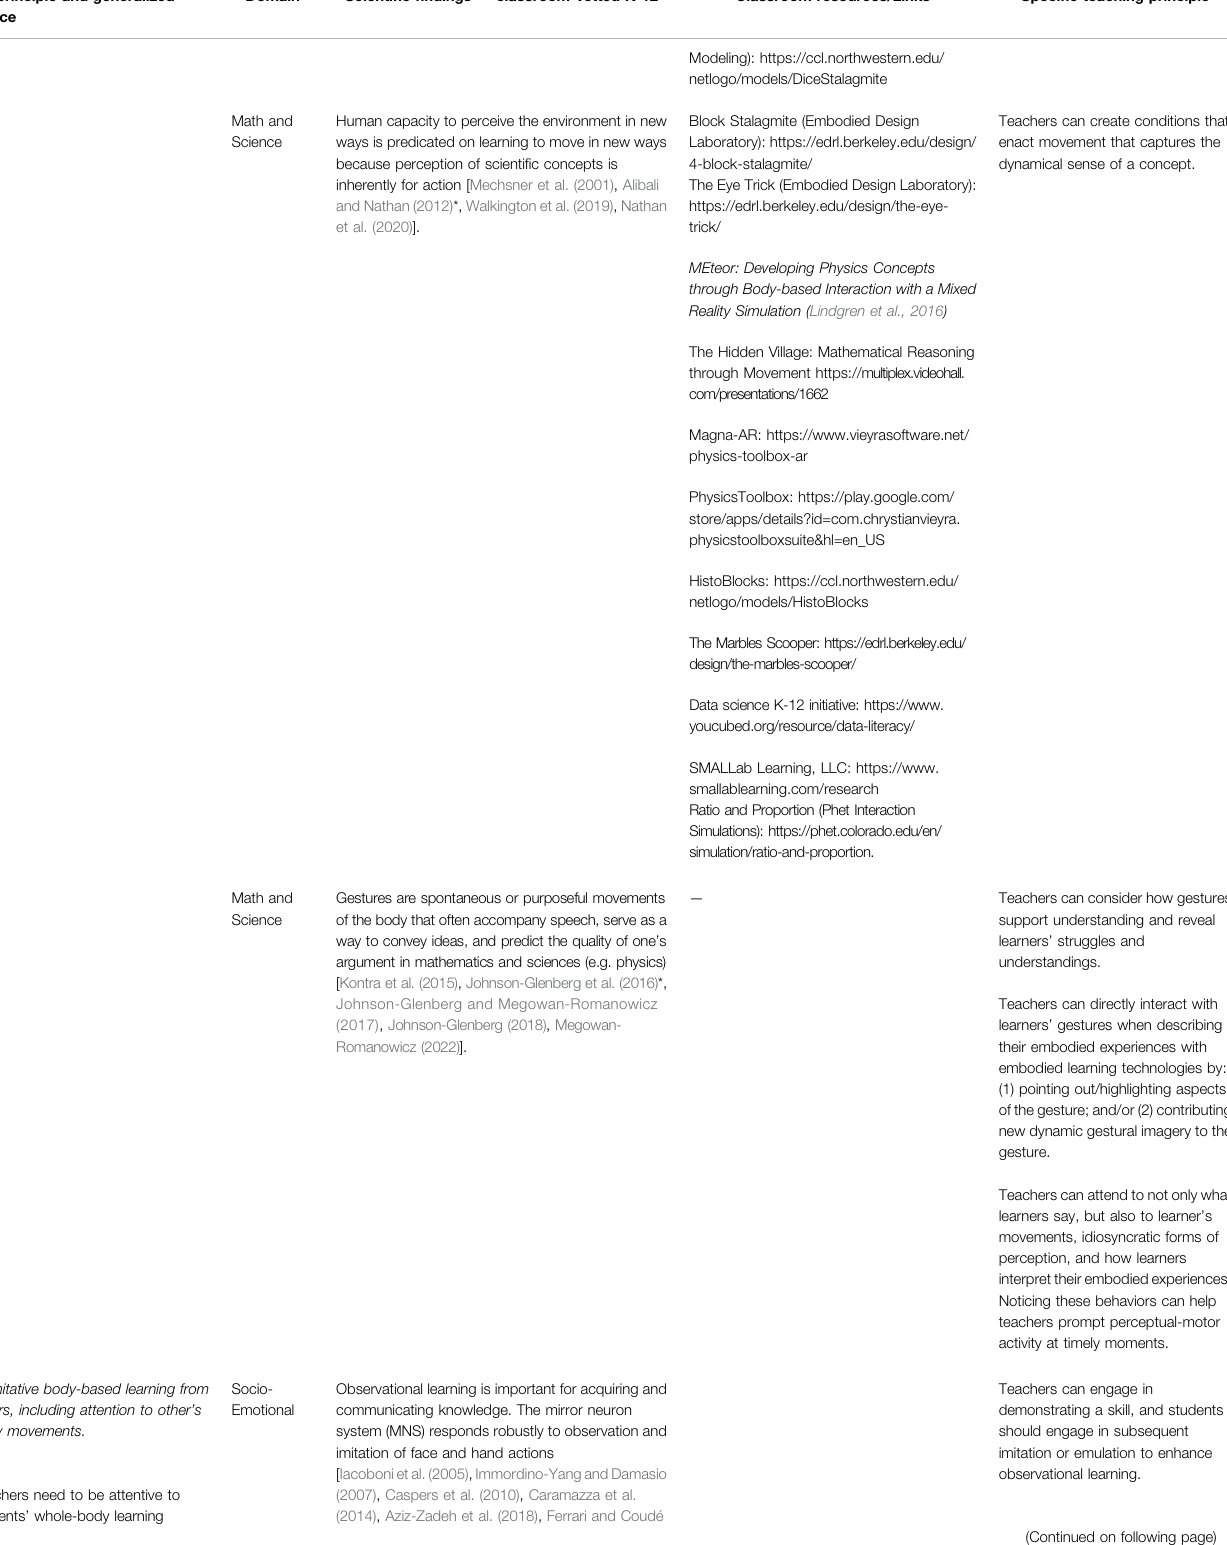
TABLE 1 | ( Continued ) Key Principles for Translational Learning Sciences Research for Embodied Cognition and Embodied Learning. EC principle and generalized